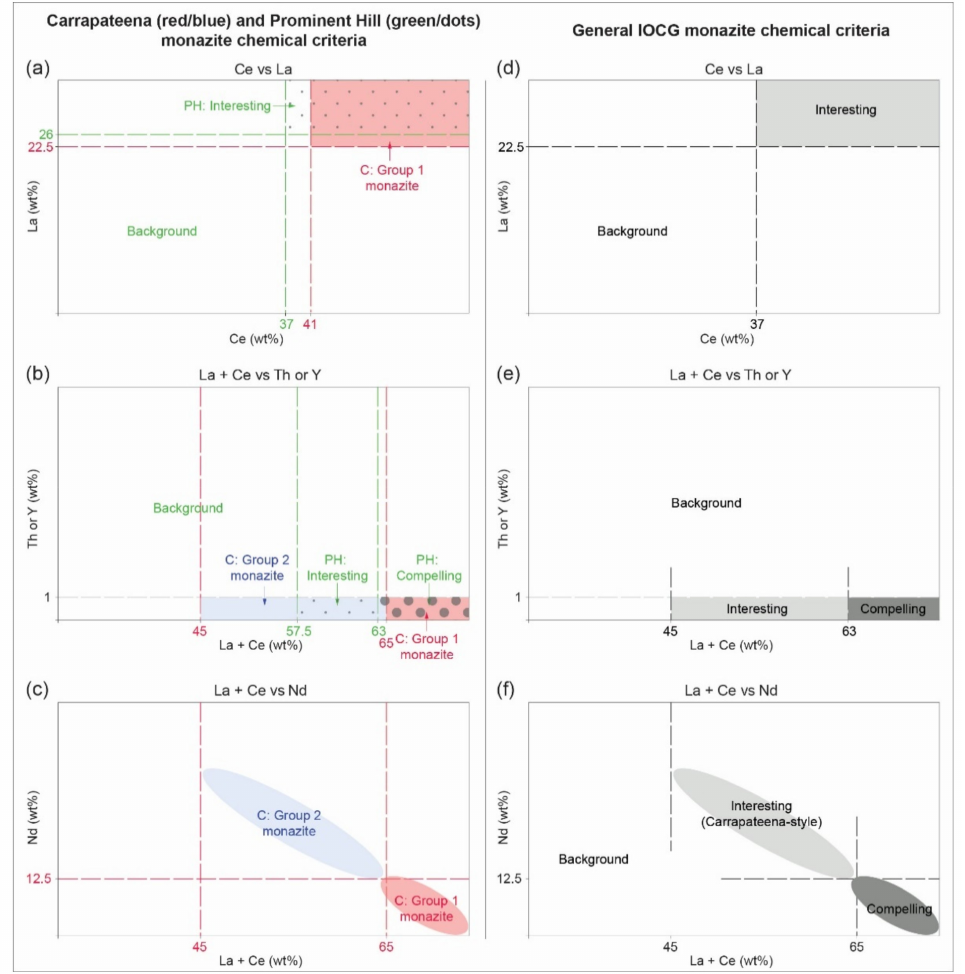
Figure 11. Monazite geochemical criteria for IOCG exploration. ( a – c ) Monazite geochemical crite- ria developed for Carrapateena (red/blue) and Prominent Hill (green/dots) using ( a ) Ce vs. La; ( b ) La + Ce vs. Th or Y; and ( c ) La + Ce vs. Nd. ( d – f ) Monazite geochemical criteria for IOCG ex- ploration in the Gawler Craton using ( d ) Ce vs. La; ( e ) La + Ce vs. Th or Y; and ( f ) La + Ce vs. Nd. Monazite geochemical exploration criteria developed for the Prominent Hill IOCG deposit is taken from